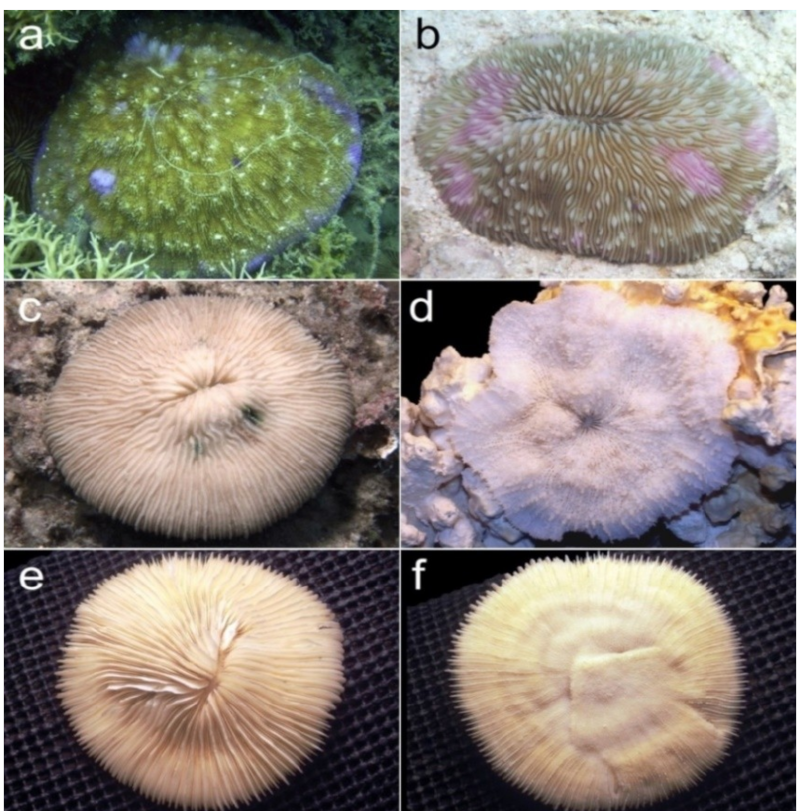
Figure 4. Shallow-water mushroom corals in zones 2–3: ( a ) Halomitra pileus at NW Pulau Peniki; ( b ) Lobactis scutaria at W Pulau Tikus; ( c ) Pleuractis granulosa at NW Pulau Kotok Kecil; ( d ) attached coral of Podabacia kunzmanni from N Pulau Panjang, 4 m depth (RMNH Coel. 24176, 18.ix.1995, coll. B.W.H.); ( e ) oral side of Lithophyllon scabra corallum from Pulau Tidung Besar (RMNH Coel. 16101, 12.v.1983, coll. B.W.H.); ( f ) aboral side of the same